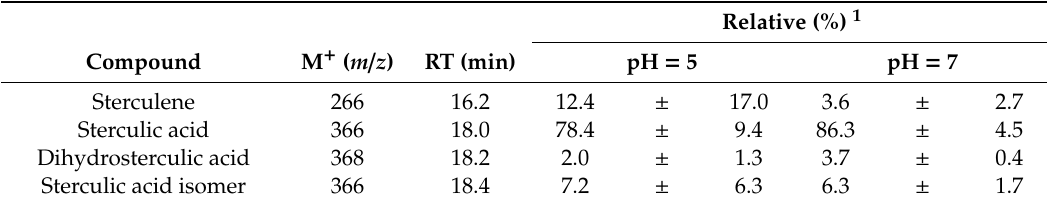
Figure 3. Expanded view of the GC-MS chromatograms obtained from the chemically synthesized sterculic acid standard after silanyzation at ( a ) pH 5 and ( b ) pH 7. Peaks: (1) sterculene (m / z 81; M + : m / z 266); (2) sterculic acid (M + : m / z 366); (3) dihydrosterculic acid (M + : m / z 368); (4) sterculic acid isomer (M + : m / z 366). Table 1. Molecular ion (M + ), retention time (RT), and relative percentage (%) of the compounds detected by GC-MS of the chemically synthesized sterculic acid standard after silanyzation at two pH